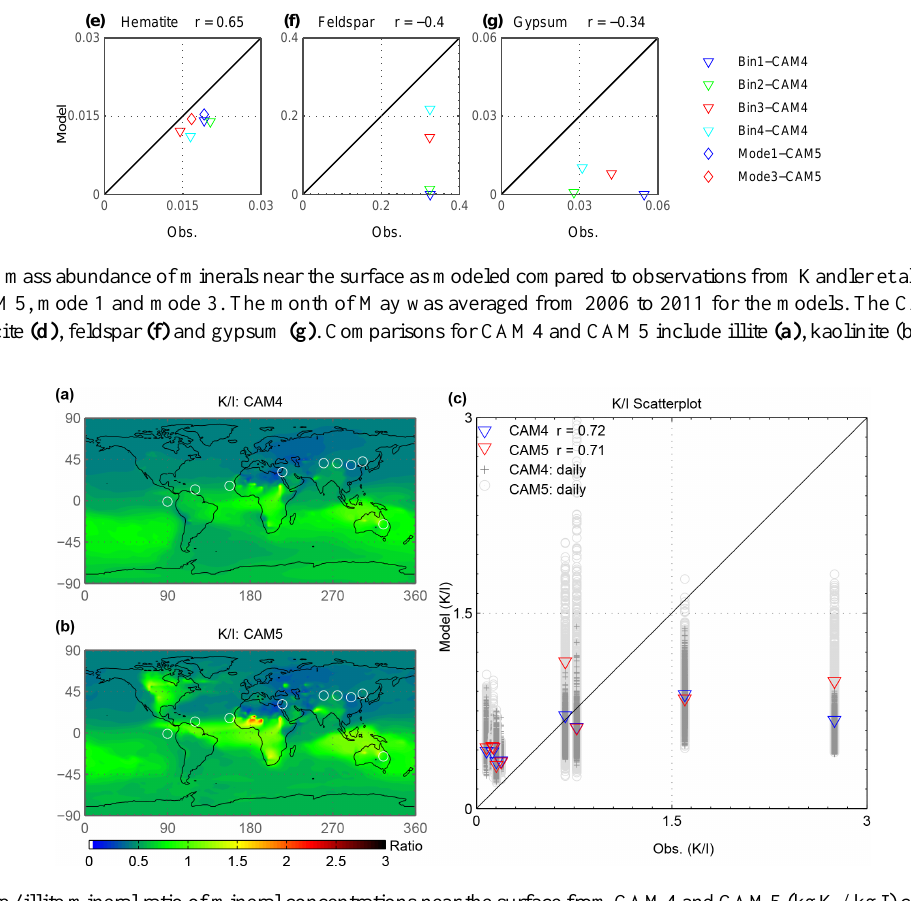
Figure 5. Kaolinite/illite mineral ratio of mineral concentrations near the surface from CAM4 and CAM5 (kgK / kgI) compared to bulk ob- servational ratios (kgK / kgI) from fieldwork by Shen et al. (2005), Glaccum and Prospero (1980), Prospero and Bonatti (1969), Caquineau et al. (1998), Kiefert et al. (1996) and Falkovich et al. (2001). Colored values in (c) represent averages for the month in which the observations occurred, while the grey symbols represent daily averaged values over the course of the simulations